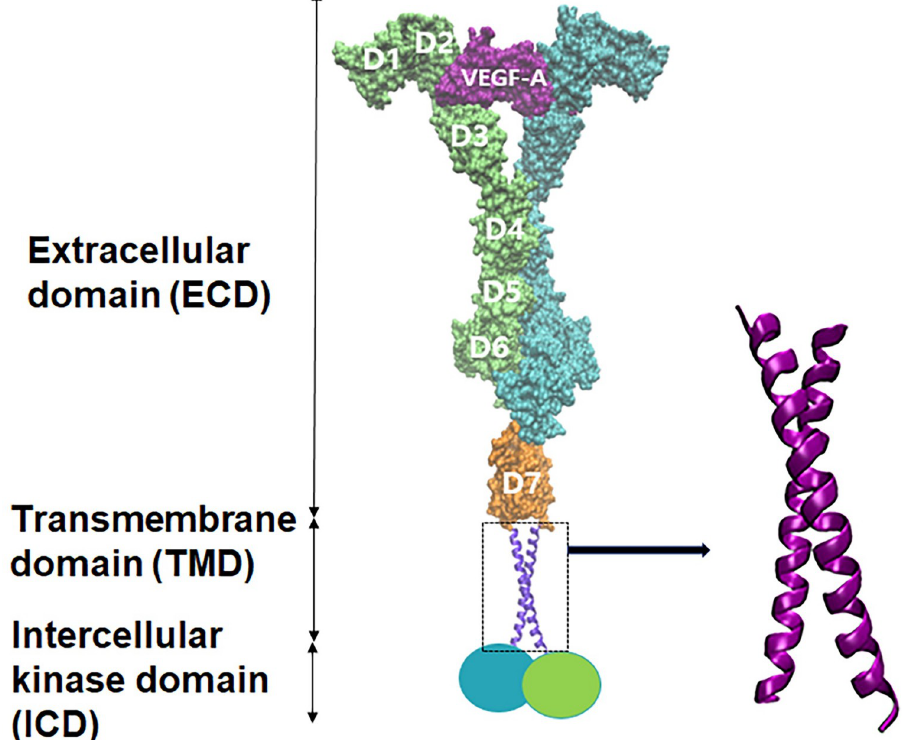
Fig 1. Schematic illustration of the ligand-bound VEGFR-2 dimer structure. The VEGFR-2 dimer is composed of ECD with seven subdomains, TMD through lipid bilayer, and ICD in cytoplasm. The magnified structure of TMD on the right is based on an experimental structure (PDB ID: